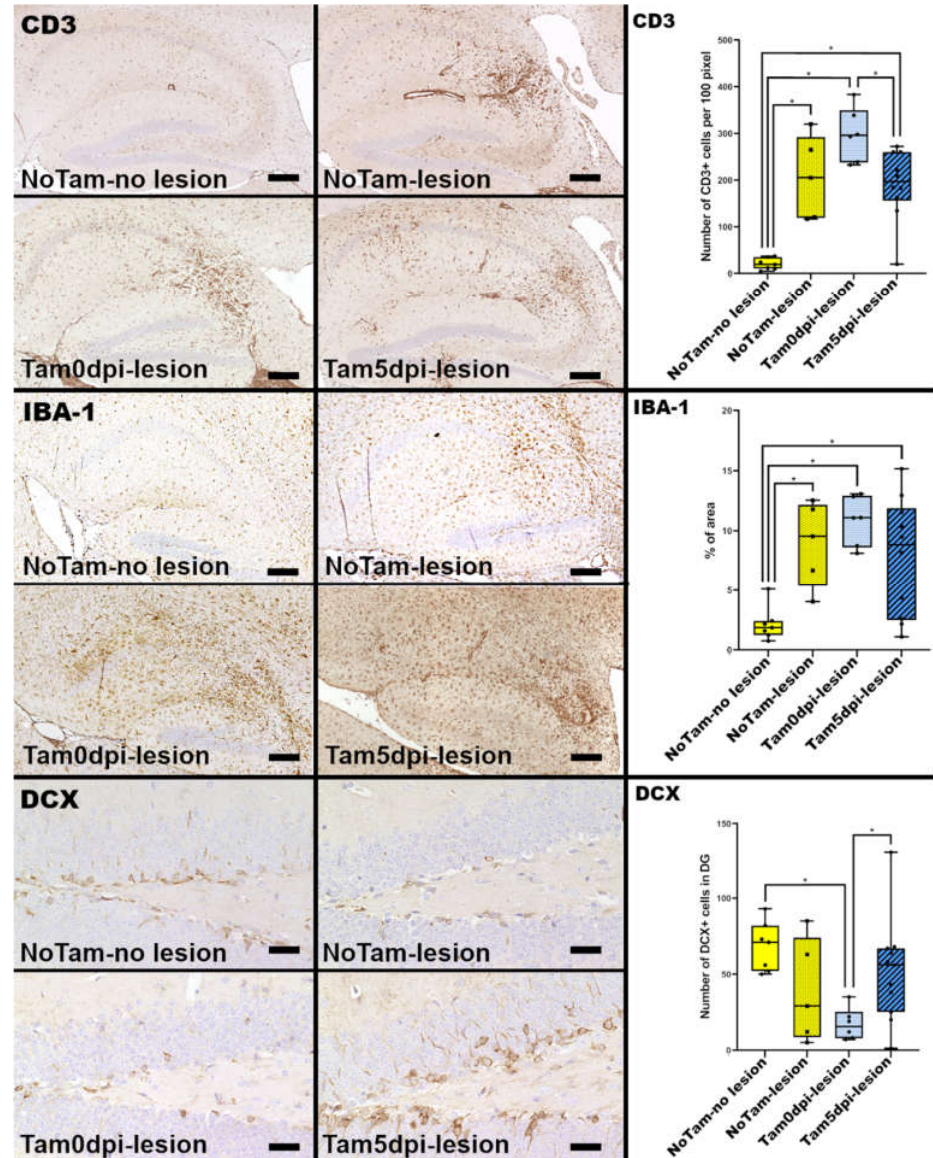
Figure 2. Immunohistochemical evaluation of hippocampi of Theiler’s murine encephalomyelitis virus BeAn (TMEV-BeAn) infected mice 14 days post-infection (dpi). Presence of neuronal loss (Figure 1) is associated with increased numbers of CD3 positive T cells and activated ionized calcium- binding associated molecule-1 (IBA-1) positive microglia/macrophages. The infiltration of CD3 and IBA-1 positive cells within the hippocampus does not differ between tamoxifen-treated and untreated animals without lesions. Tam0dpi mice show decreased numbers of doublecortin (DCX)-positive cells in the DG compared to untreated mice without lesions and Tam5dpi mice. Scale bars: 200 µm (CD3, IBA-1) and 50 µm (DCX). Statistical significant differences are depicted as * = p ≤ 0.05 (Supplementary Table S1 for each p -value individually).